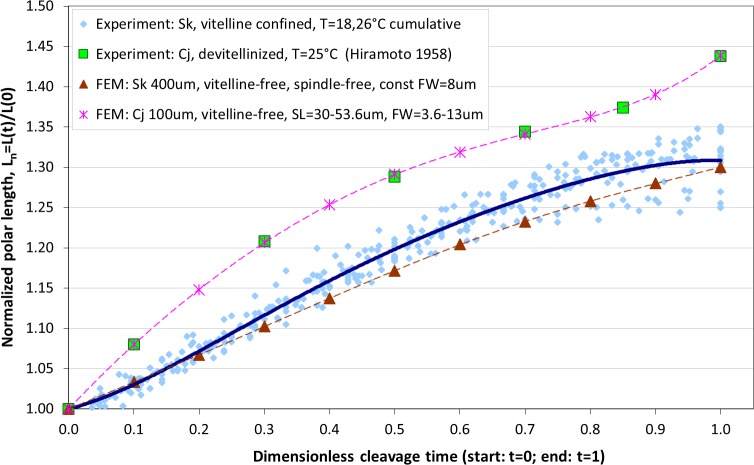
Comparison of our cumulative measurements of polar elongation of Sk (400 μm) embryonic cells vs. Cj (100 μm) data (Hiramoto, 1958) vs. FE simulations of spindle-free (i.e., Sk) and spindle-extended (i.e., Cj) contractile ring models.FE simulation of Sk cleavage is performed under assumption of vanishing effects of spindle polarization and constant furrow width (FW = 8 μm, i.e., 2% of the Sk egg cross-section), while division of the Cj cell is modeled by iterative fitting of variable furrow width (FW = 3.6–13 μm, i.e., 3.6–13% of the Cj egg cross-section) and spindle length (SL = 30–53.6 μm) to polar elongation measurements.